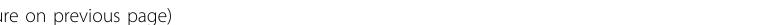
Fig. 4 Local regulatory effects of rs12373123. A Chromatin interaction (orange links) and tissue-speci fi c eQTLs (green links) for rs56201815 and rs12373123 on chromosome 17 identi fi ed from the exome-wide association analysis of age-of-onset of AD in APOE ε 4 non-carriers in ADSP. A gene that is in chromatin interaction or an eGene with these SNPs is highlighted in orange or green, respectively. A gene highlighted in red indicates both features. B Normalized cell type-speci fi c (astrocytes, excitatory neurons, inhibitory neurons, microglia, OPCs, and oligodendrocytes) expression of MAPT, ARL17B , and GRN across the genotype groups of rs12373123 from 44 subjects (including 13 rs12373123-T/C carriers and 2 rs12373123-C/C carriers) in the snRNA-seq data in the prefrontal cortex. All cells in each cell type from each subject were fi rst pooled, and the gene expression was aggregated by subjects. The gene expression was then adjusted for age, sex, and AD